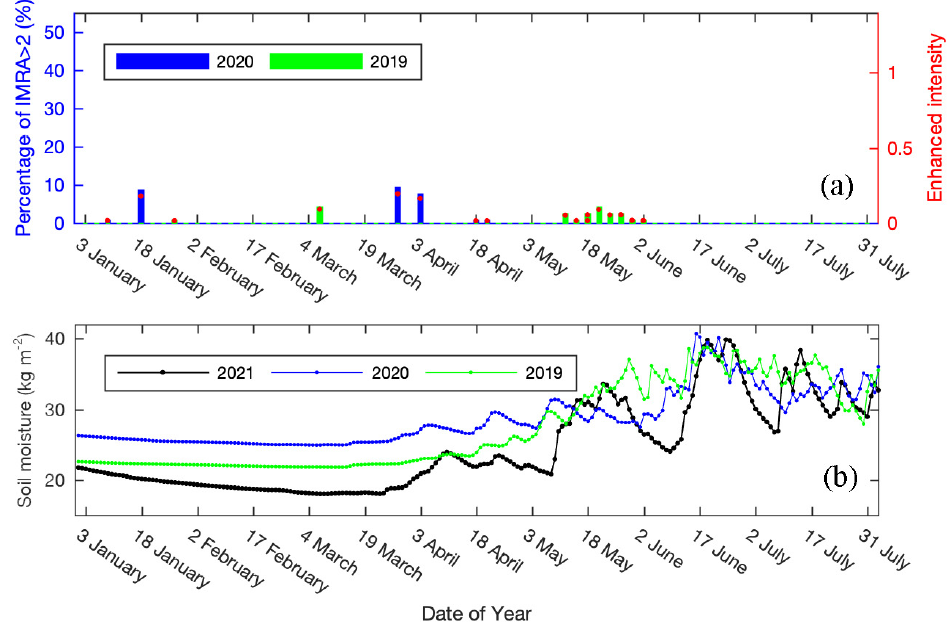
Figure 4. Time series of IMRA > 2 in the seismogenic fault zone ( a ) and soil moisture ( b ) during the period of January–July in 2019 and 2020.